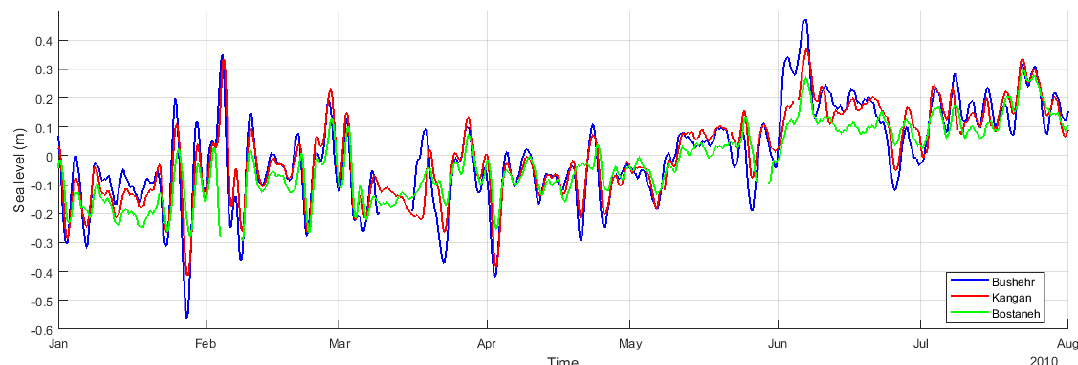
Figure 10. Low ‐ pass ‐ filtered sea ‐ level records at Bushehr, Kangan, and Bostaneh stations. The same low ‐ pass filter was been applied to the wind velocity components and MSLP data.